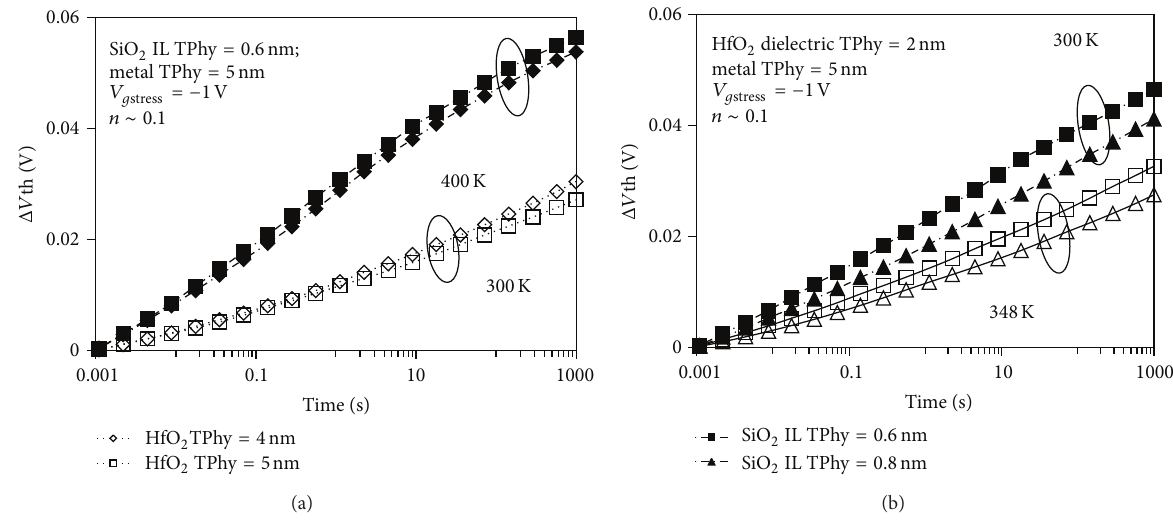
Figure 6: Power-law time dependence of simulated Δ𝑉 th for variation of physical thickness (TPhy) for (a) HfO 2 layer and (b) SiO 2 IL.